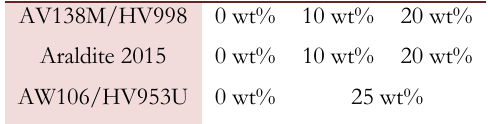
Figure 1: Tensile stress-strain curves of the epoxy adhesives without particles.